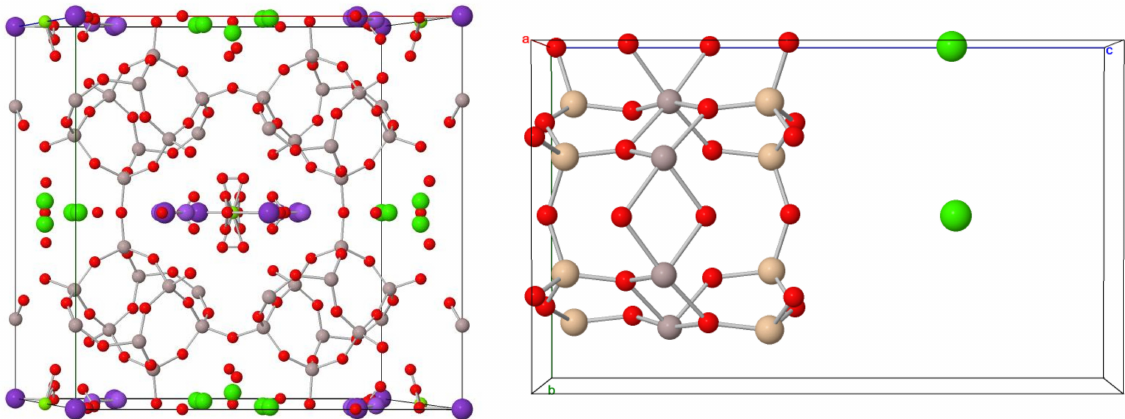
Figure 1. In the left Zeolite Clinoptilolite and in the right montmorillonite taken from mindat.org. Red ball: Oxygen, Light brown: Silica, Gray: Aluminum, Purple: Sodium or Potassium, Green: Sodium or Calcium.